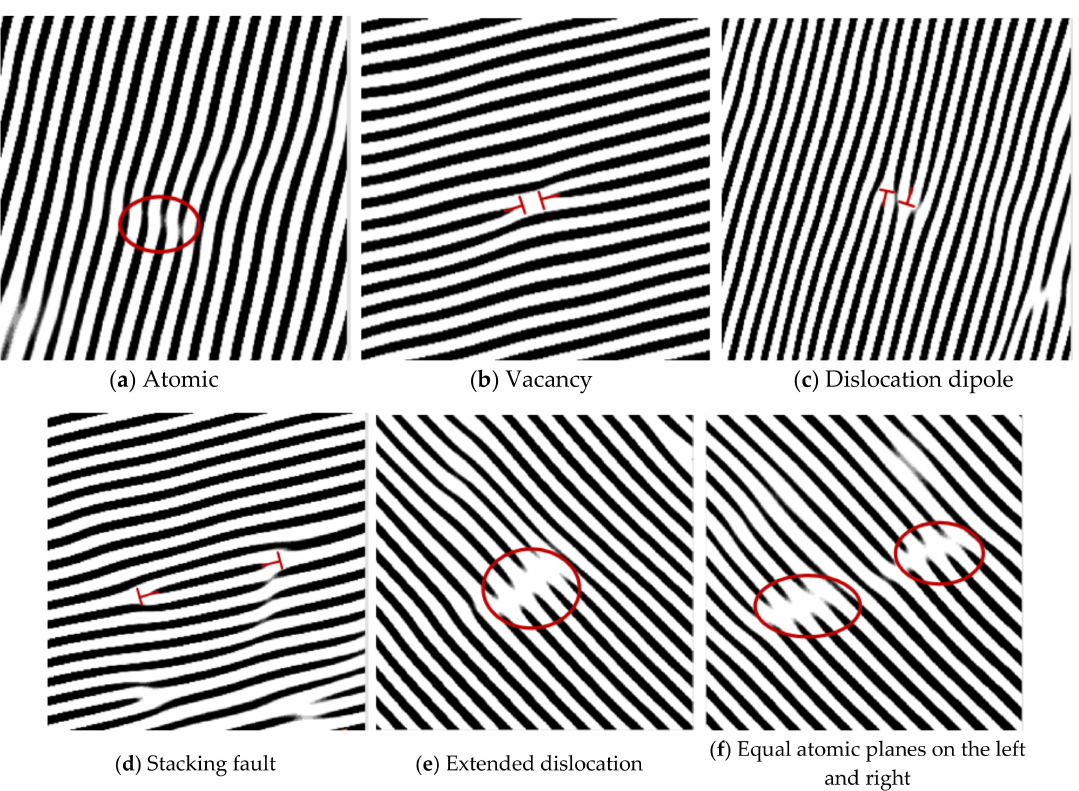
Figure 9. Different types of dislocation within the NV E690 cladding layer after LSP. Dislocation dipoles are grain defects that commonly occur in metal materials during cold working. The effects of multiple dislocation dipole aggregations on the macroscopic properties of materials cannot be ignored [22]. The formation of these defects is related to the movement of screw dislocations with dislocation jogs, as illustrated in Figure 10. When the height of the dislocation jog OO (cid:48) is only on the scale of a few atoms, the screw dislocation MN will then drag the dislocation jog OO (cid:48) together under the action of strong external shear stress and will leave a series of point defects on the movement path, as shown in Figure 10a. When the height of the dislocation jog OO (cid:48) reaches 20 nm, the dislocation jog is then equivalent to pinning because of its long length, and the dislocation lines of the upper and lower parts of the dislocation jog are located far apart and have little effect on each other. The dislocations at the two ends form a straight line, where the dislocation jog acts as the axis of rotation, and the line rotates on the sliding surface, as shown in Figure 10b. When the dislocation jog height OO (cid:48) is within the range of both dislocations, it is then difficult for the dislocation line MN to move forward with the dislocation jog OO (cid:48) , and the section of the dislocation line affected by the dislocation jog will then bend under the action of the applied stress. Along with the continuous movement of the dislocation, a set of elongated dislocation lines with different signs (also called a dislocation dipole) remains on the slip surface, and the direction of the dislocation line is then perpendicular to that of its Burgers vector, which can be regarded as a formation composed of a cluster of edge dipoles, as shown in Figure 10c. The internal dislocations of the NV E690 cladding layer are multiplied by LSP, and the dislocation dipoles are distributed in pairs. Dislocation dipoles occurring in the same atomic row and several atomic rows of the material are shown in Figures 9c,d,